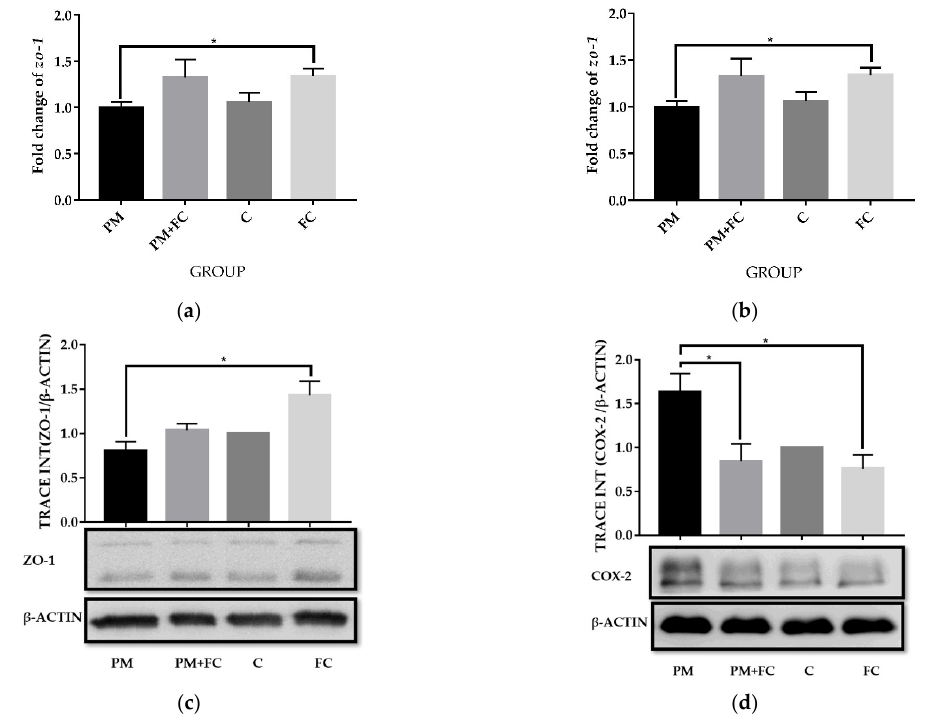
Figure 7. The expression levels of ZO-1 and COX-2 in mouse lung tissues: ( a ) mRNA expression levels of zo-1 ; ( b ) mRNA expression levels of cox-2 ; ( c ) the protein levels of ZO-1; ( d ) the protein levels of COX-2. * p < 0.05.